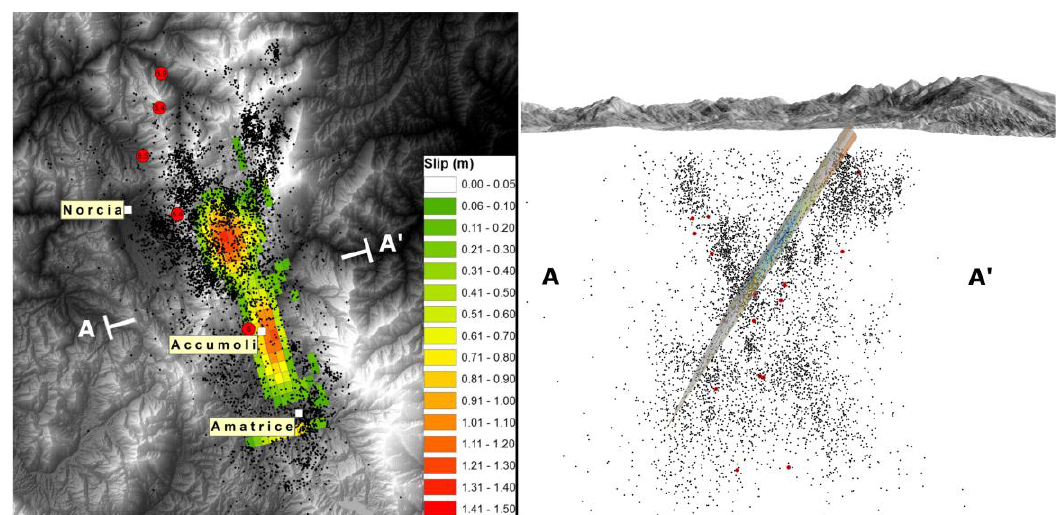
Figure 3 . Modelling results. a) Co-seismic fault slip distribution from the InSAR data modelling. The mainshock and the M 5.3 aftershock are reported with the red pentagon, while the M<5 aftershocks are shown with black dots. b) 3D view of the fault below the topographic surface. The view is from SSE along the strike direction (SSE-NNW, section A-A’ in panel (a)). The red dots are the largest events (M≥4) and black dots are the M<4